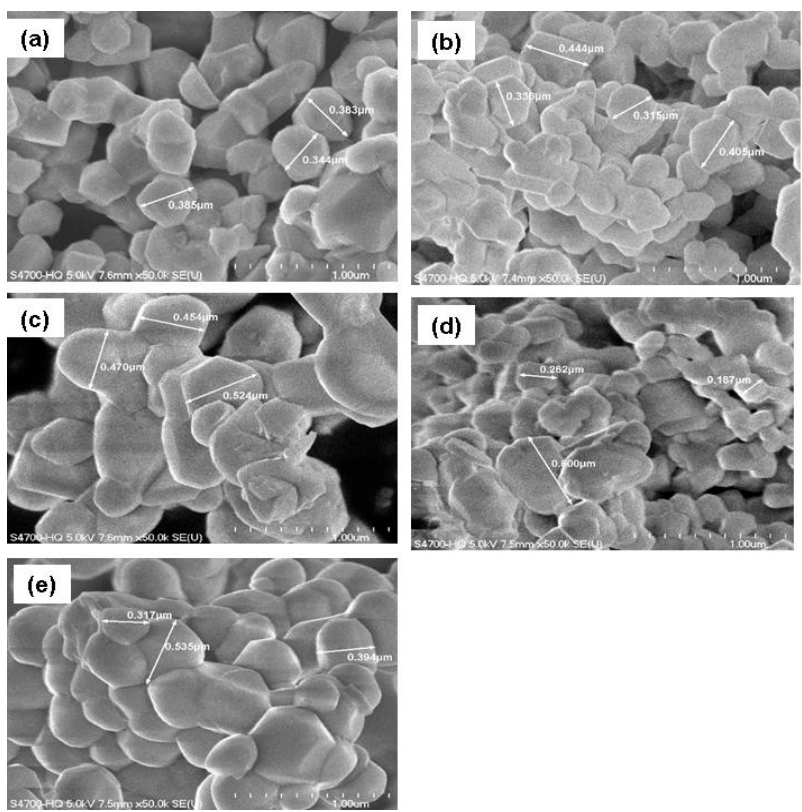
Figure 3. Field-emission SEM images of ( a ) undoped and ( b – e ) M -doped NMC333 powders with Figure 3. Field ‐ emission SEM images of ( a ) undoped and ( b – e ) M ‐ doped NMC333 powders M = Al, Mg, Fe, Zn, with M = Al, Mg, Fe, Zn, respectively.